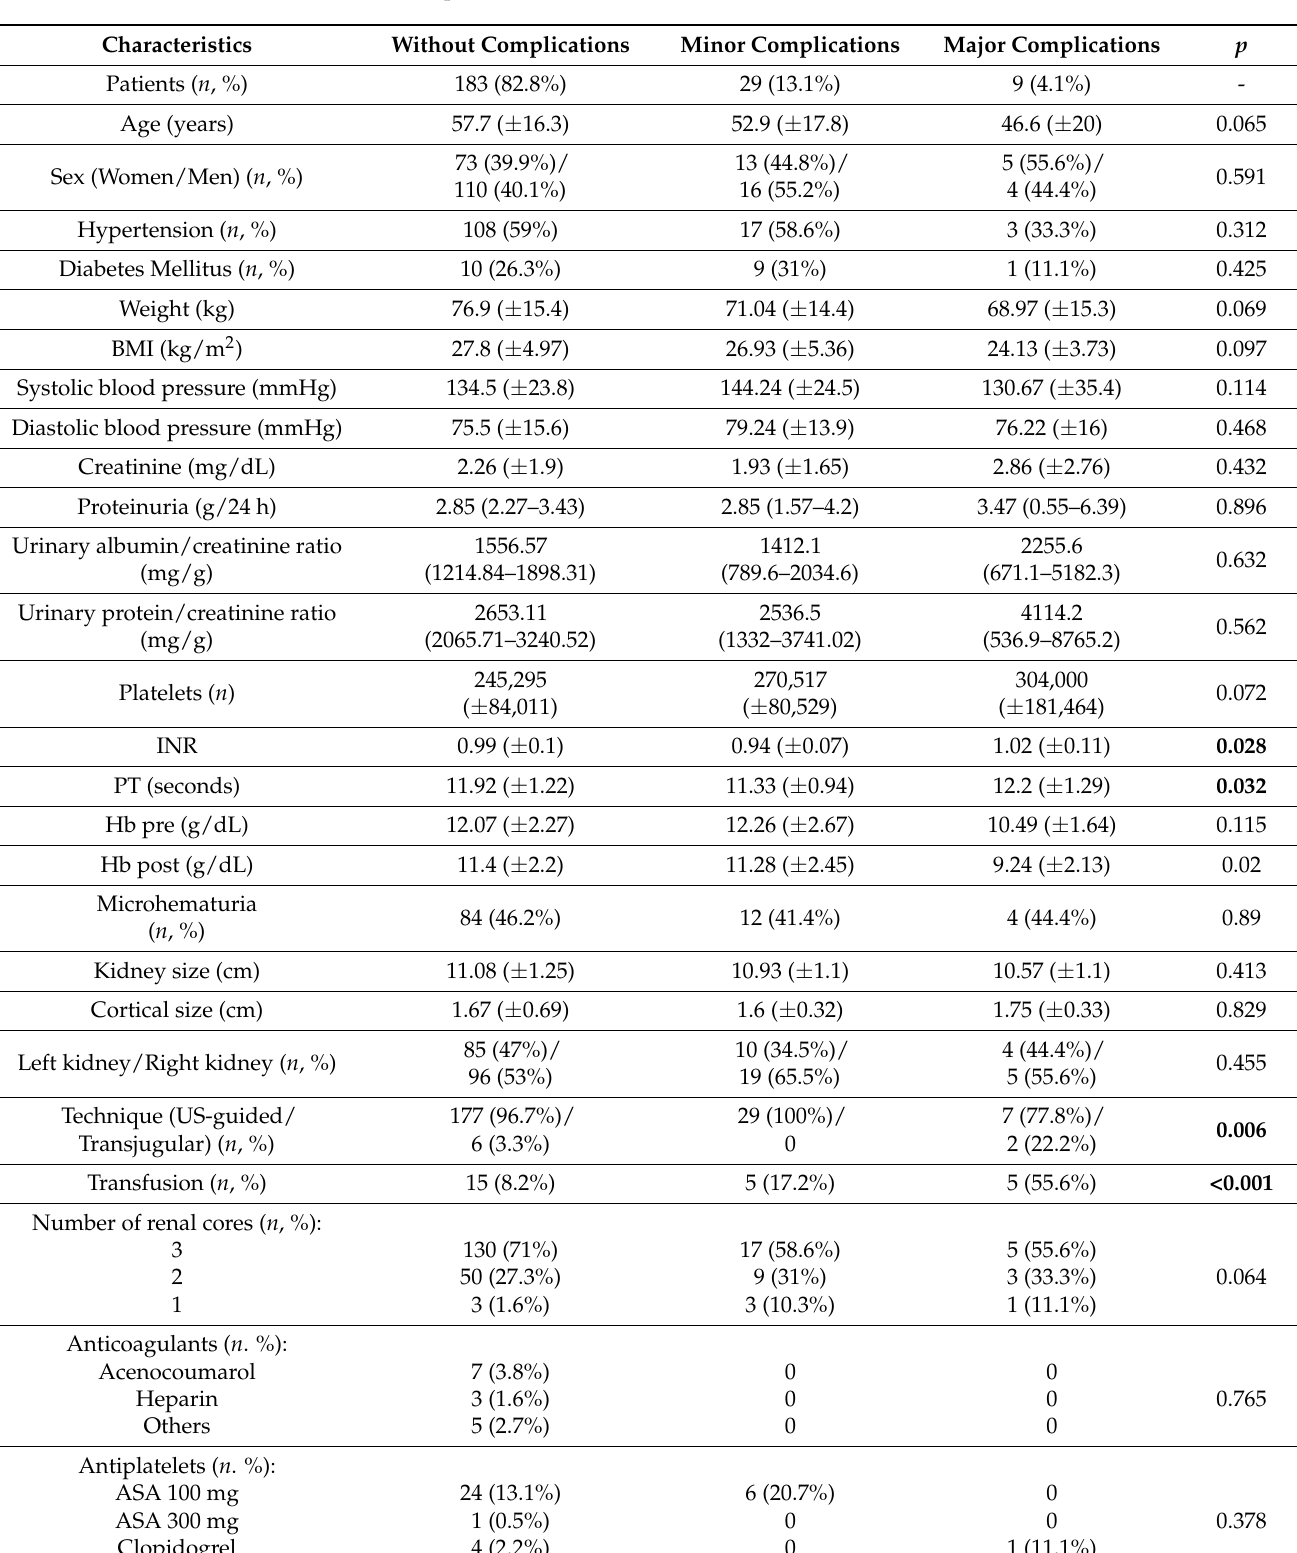
Table 5. Baseline characteristics of patients according to presenting complications: major, minor, or without